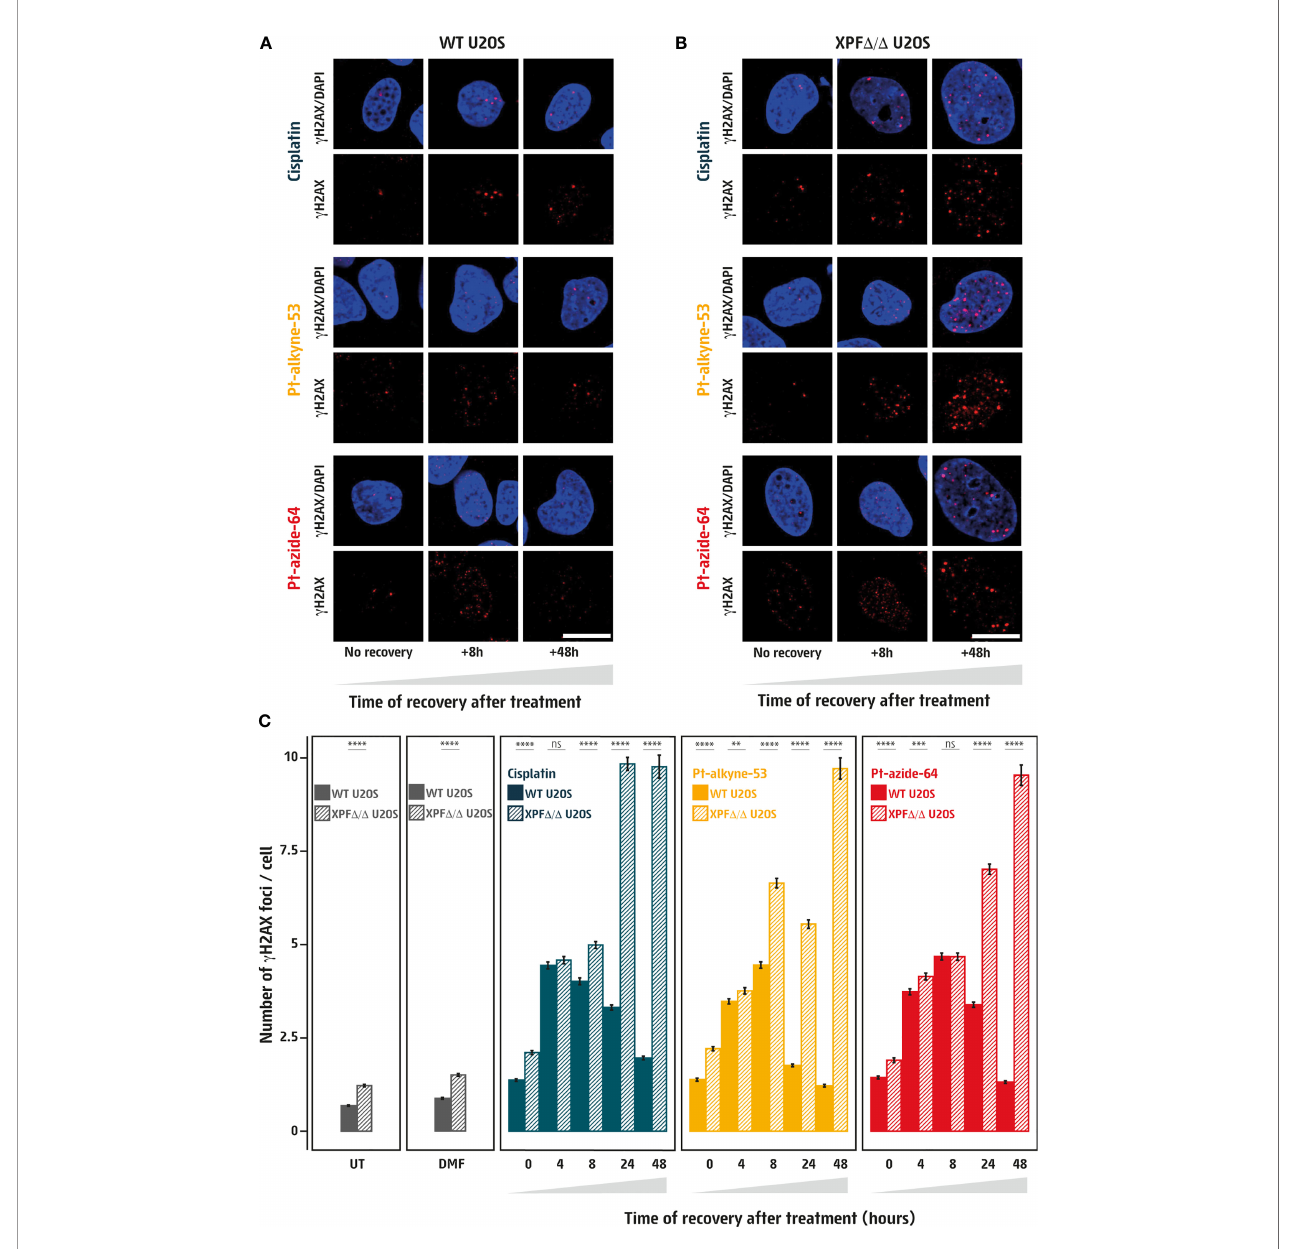
FIGURE 3 | Pt-alkyne-53 and Pt-azide-64 induce DNA damage that is cleared through DNA repair. (A, B) Visualization of the DNA damage marker g H2AX (in red) within DAPI stained nuclei (in blue) in wildtype [WT, (A) ] or XPF de fi cient [XPF D / D , (B) ] human U2OS cells. Cells were untreated (UT), or treated for 3 hours with vehicle (DMF), 1 m M cisplatin, 5 m M Pt-alkyne-53 or Pt-azide-64, followed by culturing the cells in compound-free media for up to 48 hours. Images were acquired on an Olympus spinning disk confocal microscope, scale bar represents 20 m m. (C) Quanti fi cation of images corresponding to conditions in (A, B) represented as mean number of g H2AX foci per nucleus. A minimum of 1,700 cells were quanti fi ed for each condition, using CellPro fi ler, from images acquired with an Opera high-throughput microscope. Error bars represent standard error of the mean. P-values were calculated using t-test. **<0.01, ***<0.001, ****<0.0001, ns, not signi fi